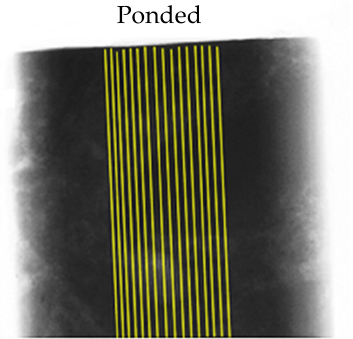
Figure 4. Considered region for data analysis in each radiograph.